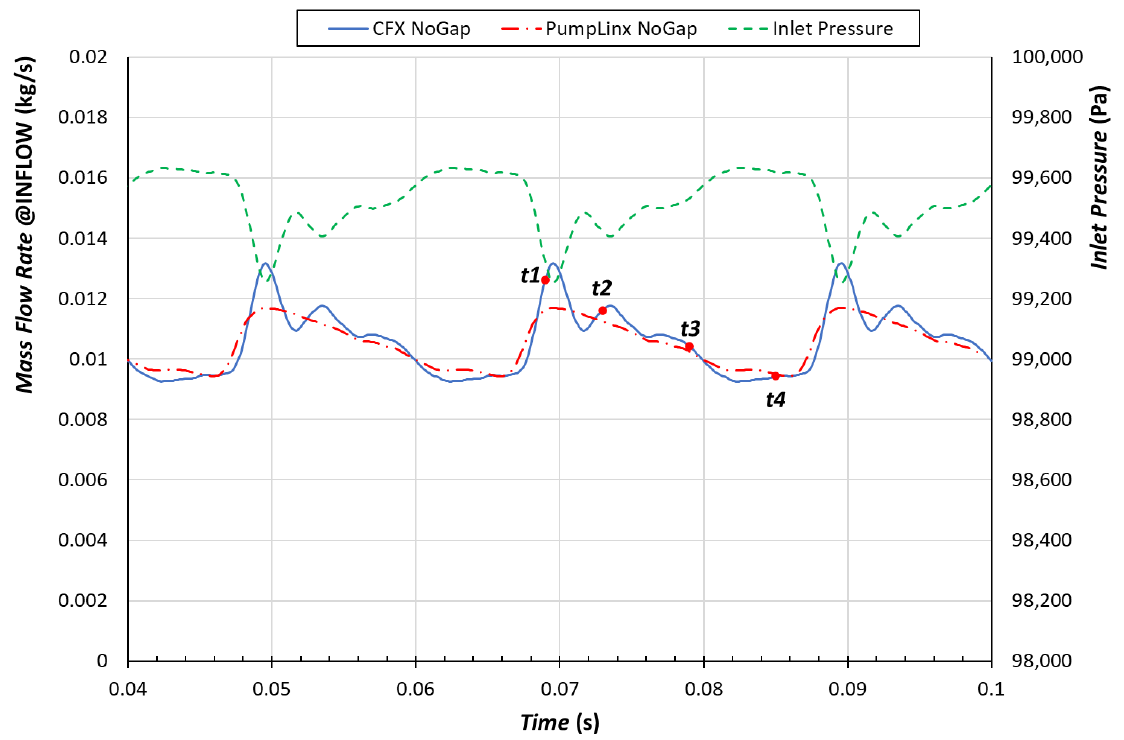
Figure 8. Vector plots of the flow field on an axial section plane for three different instants during the last revolution (CFX).